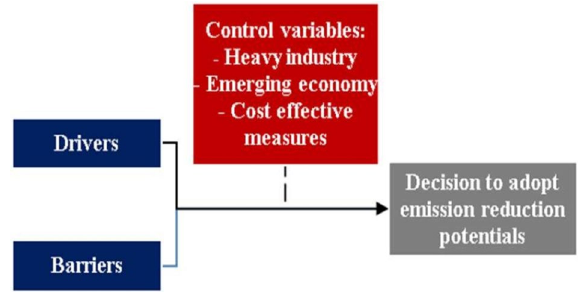
Figure 3. Theoretical framework of factors that influence the decision to adopt emission reduction measures in heavy industry in an emerging